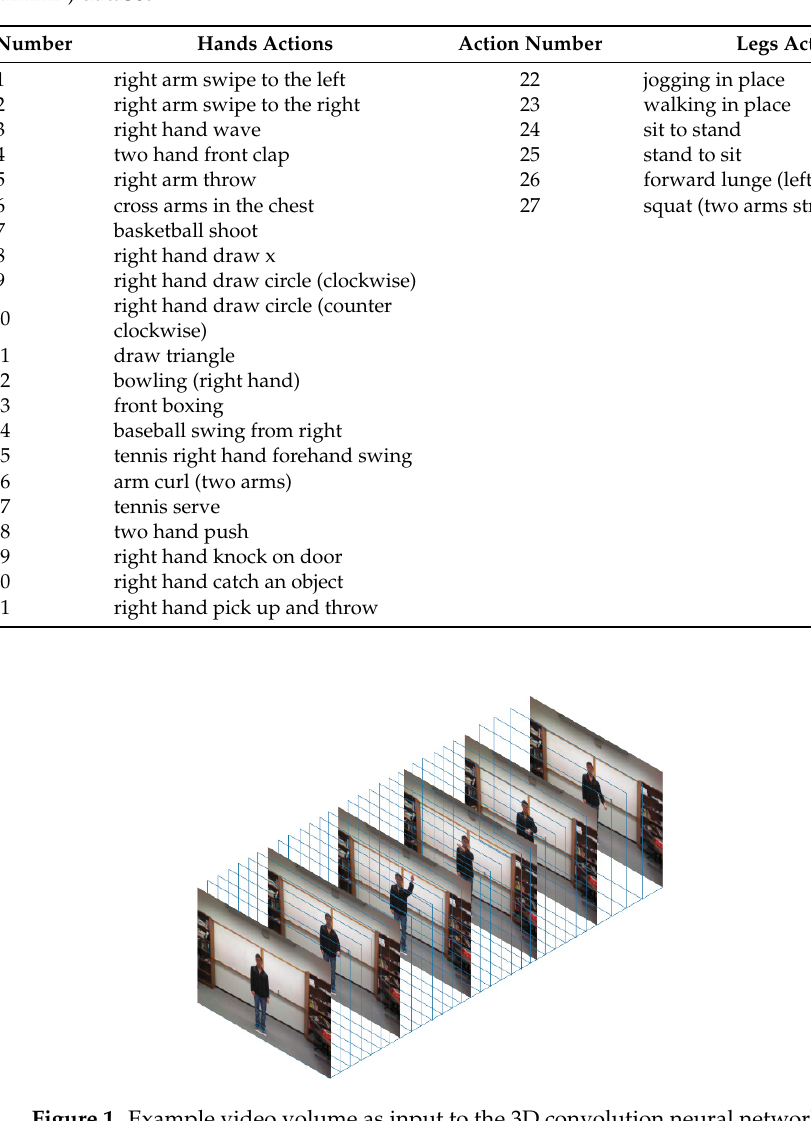
Table 1. Actions in the University of Texas at Dallas Multimodal Human Action Dataset (UTD-MHAD) dataset.